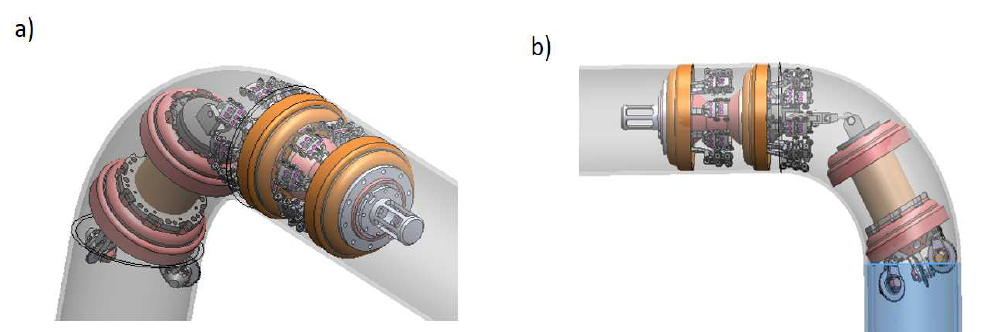
Figure 20. Final design for the distribution of the sensor carriers in the PIG. ( a ) isometric view; ( b ) lateral